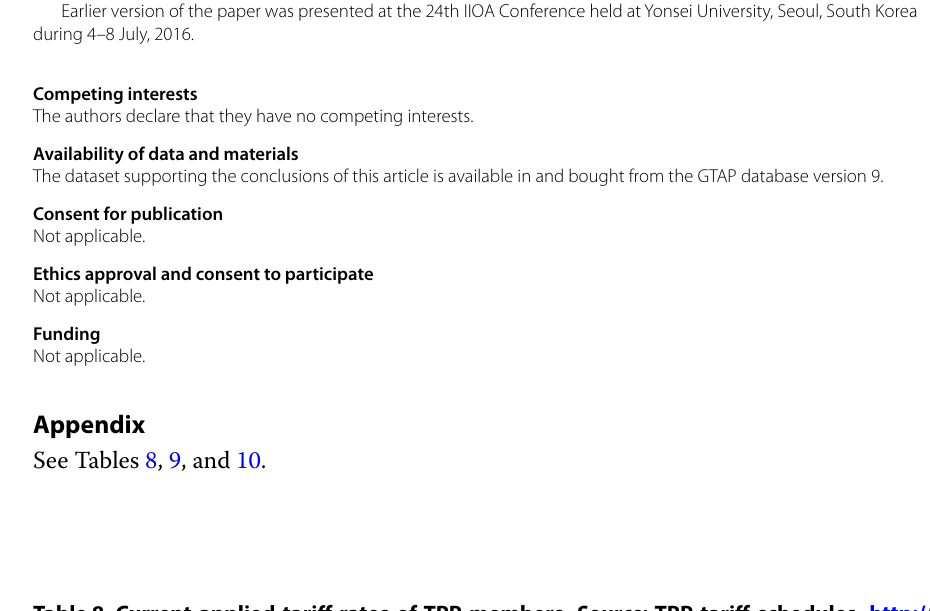
Table 8 Current applied tariff rates of TPP members. Source : TPP tariff schedules,